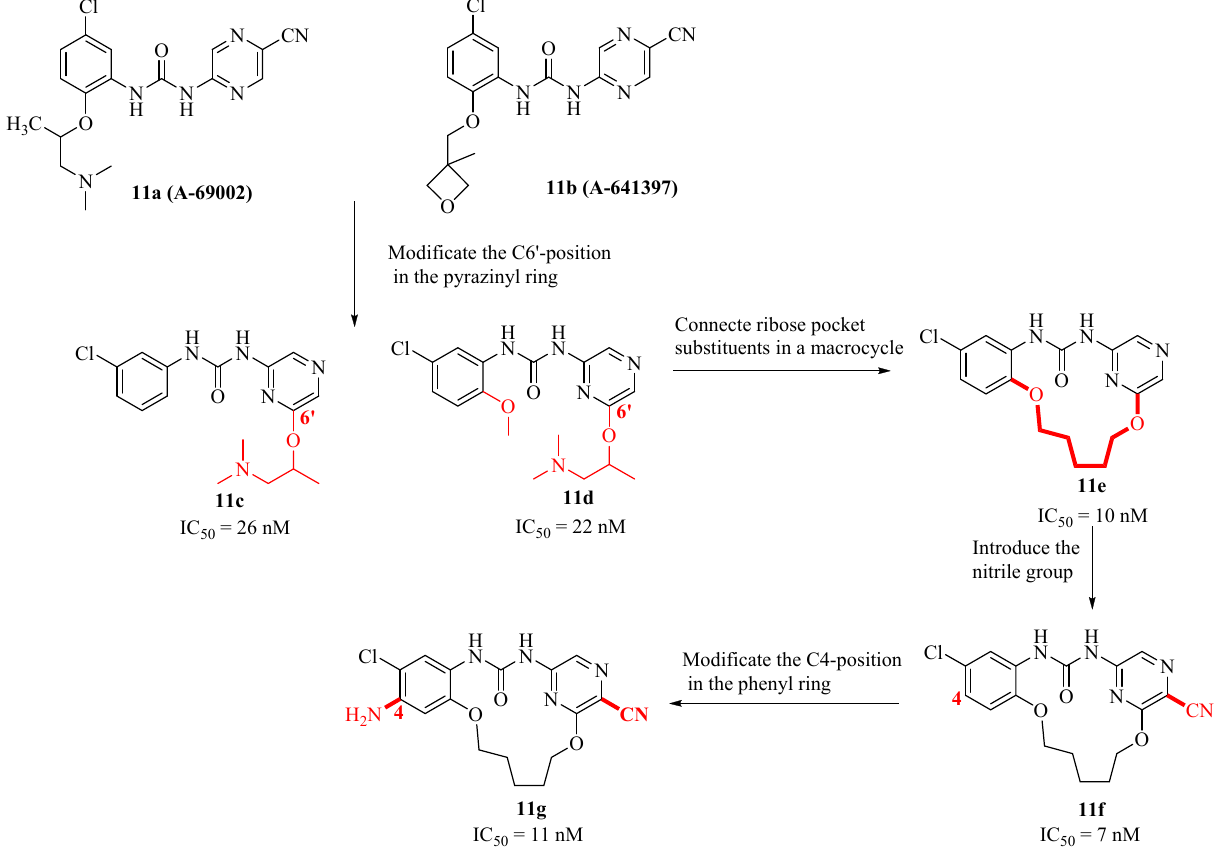
Figure 13. Macrocyclic checkpoint kinase 1 inhibitors.